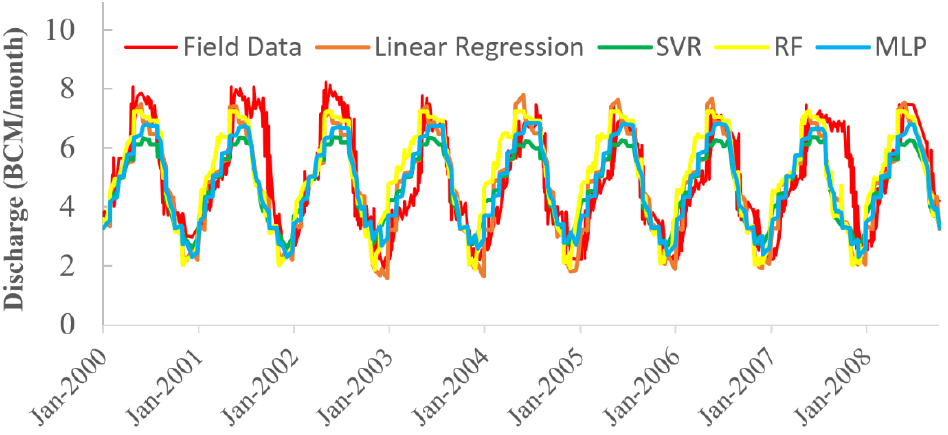
Figure 6. Comparison between field data and bias-corrected data using RF, SVR, and MLP methods at Aswan High Dam Downstream. Table 1. Nash–Sutcliffe model efficiency coefficients for the bias-corrected inflow and outflow data using different methods.